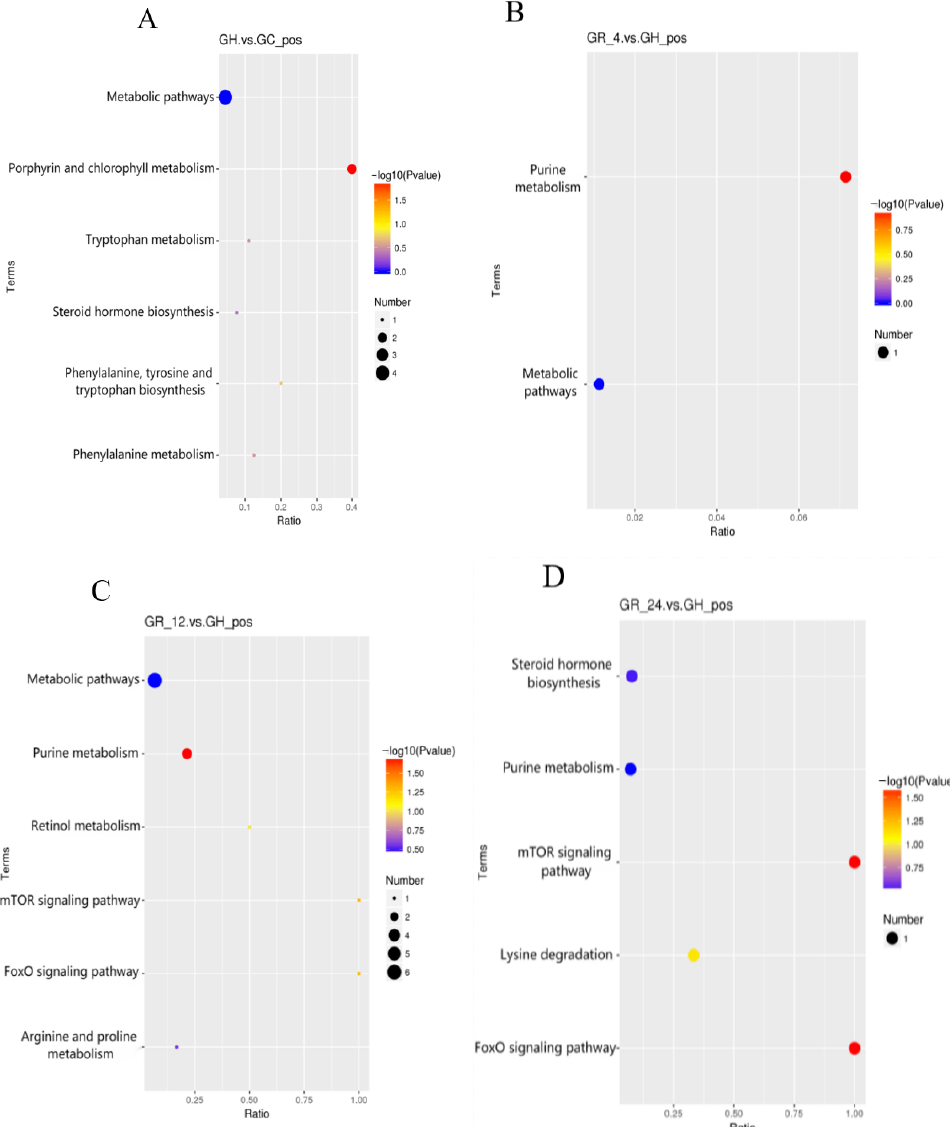
Figure 4. The KEGG pathways most significantly enriched in the metabolites which were differentially abundant between group GH and ( A ) group GC, ( B ) group GR_4, ( C ) group GR_12; and ( D ) group GR_24. In all panels, the Rich factor (the ratio of the number of differentially abundant metabolites in the corresponding pathway to the total number of annotated metabolites) is plotted on the abscissa; higher Rich factors correspond to greater enrichment. Dot color corresponds to significance (deeper reds are more significant), and dot size reflects the number of differentially abundant metabolites in the corresponding